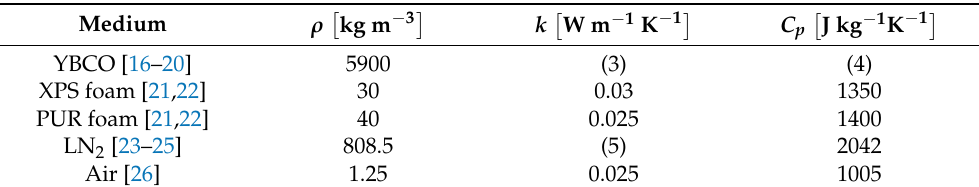
Table 1. Values and characteristics considered for ρ , k , and C p .